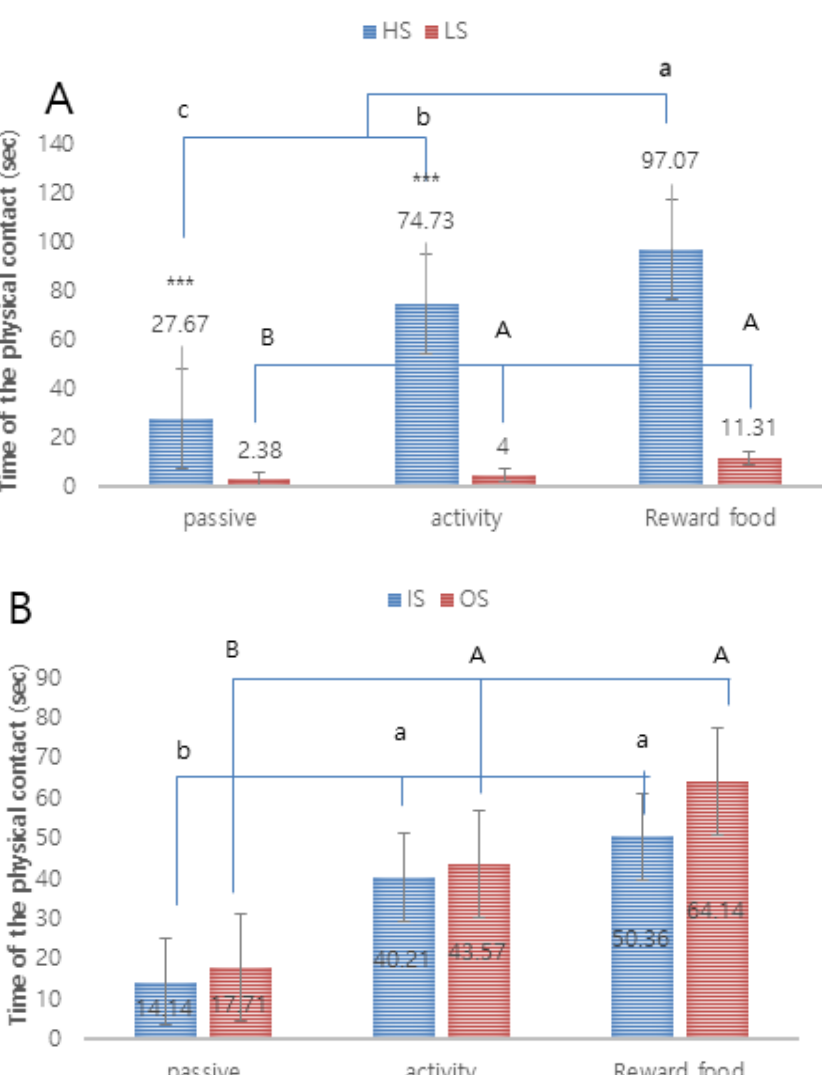
Figure 3. Behavioral changes in dogs by stages in the 9 social behavior test categories. ( A ): Comparison between HS group and LS group. A,B mean a significant di ff erence for each stage within the same LS group. a–c means the significant di ff erence by step within the same HS group ( p < 0.05). Levels of significance: *** p < 0.001. ( B ): Comparison between IS group and OS group. A,B mean a significant di ff erence in stages within the same OS group. A,B mean a significant di ff erence in stages within the same OS group. a,b means a significant di ff erence by step within the same IS group ( p < 0.05). Table 2. Results of the nine social behavior test categories.